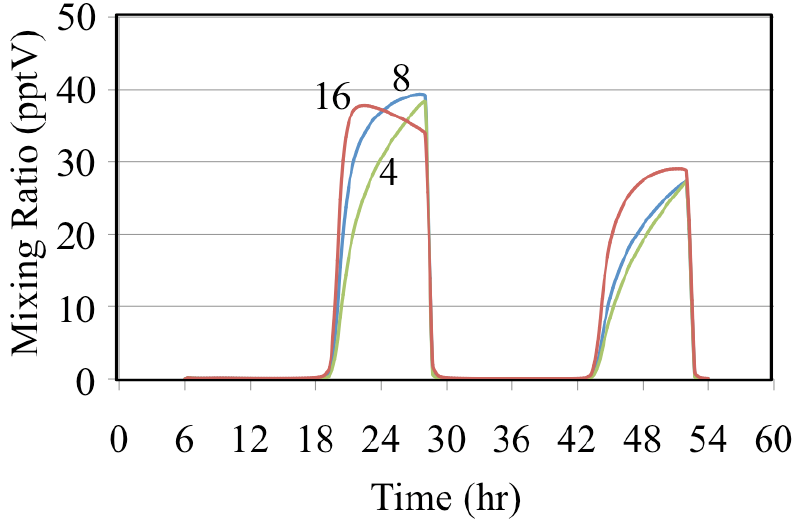
Figure 11. Nitrate radical mixing ratios for the ethene cases. The number indicates the initial VOC/NO ratio in x